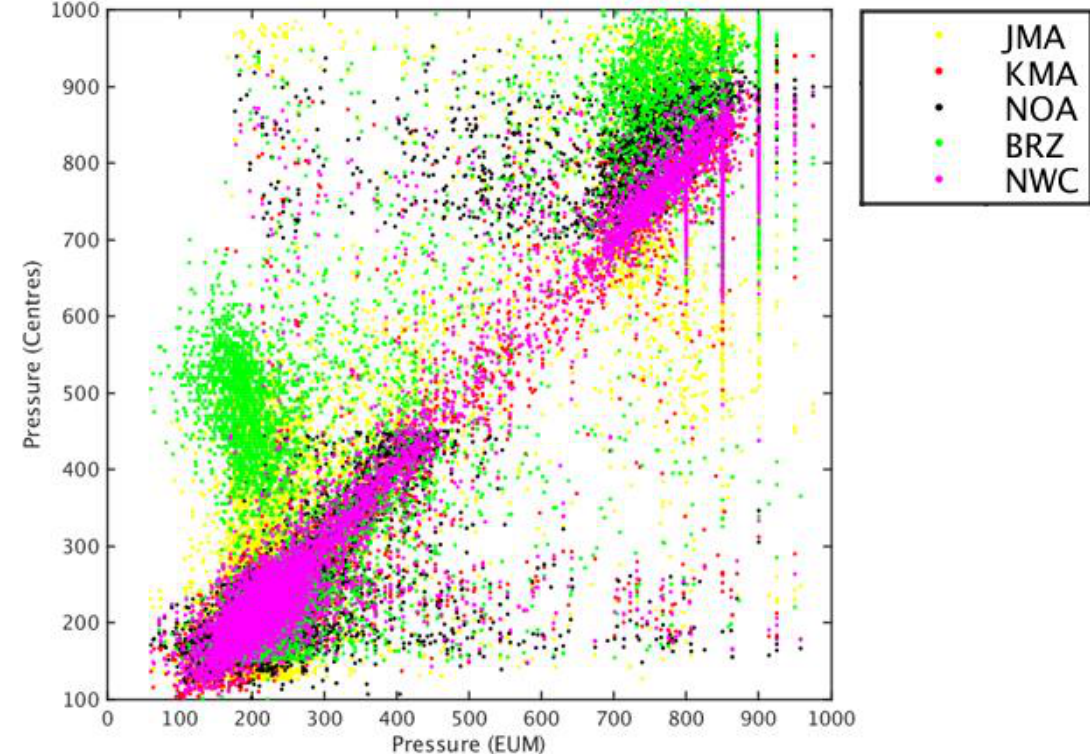
Figure 4. Scatterplot of collocated AMV pressures for Experiment 1, using CQI >= 50% and a collocation distance up to 55 km, for each center versus EUM AMV pressures (BRZ in green; JMA in yellow; KMA in red; NOA in black; NWC in magenta).